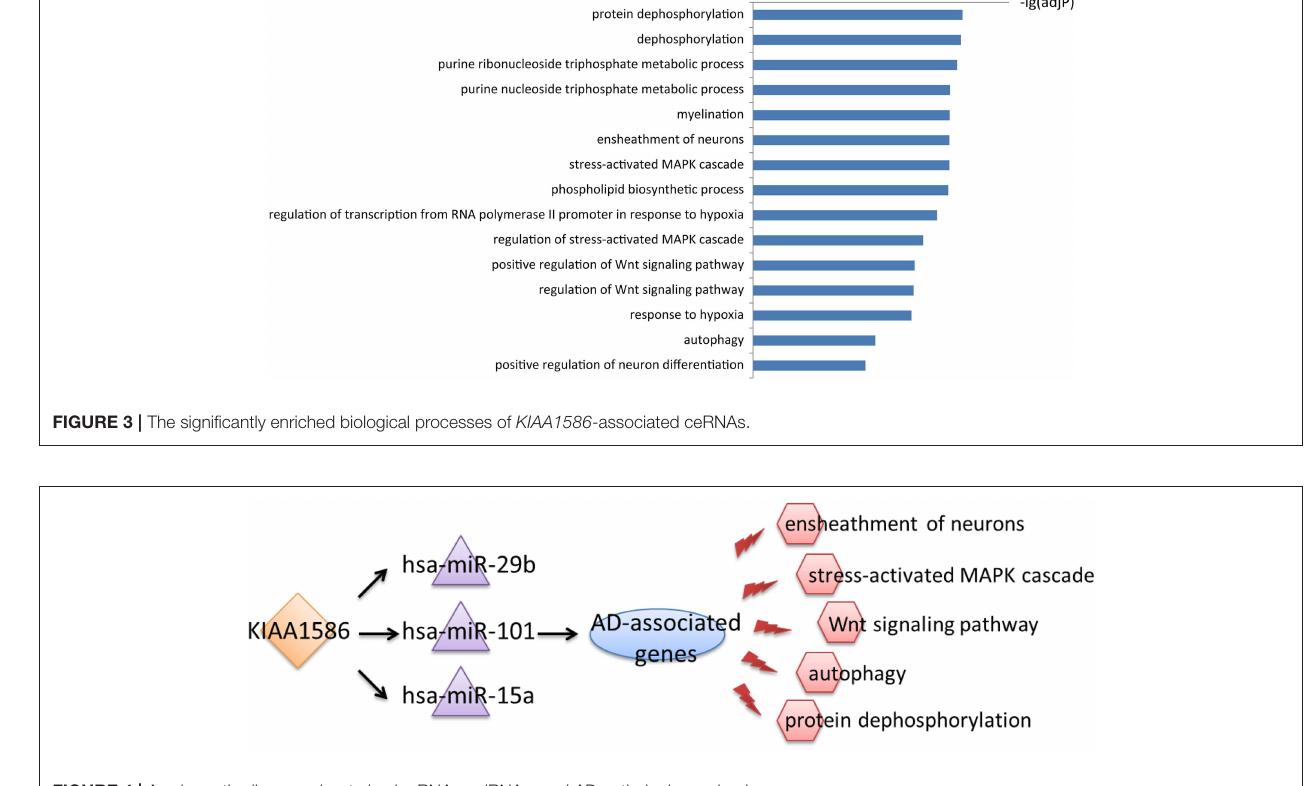
Frontiers in Bioengineering and Biotechnology |